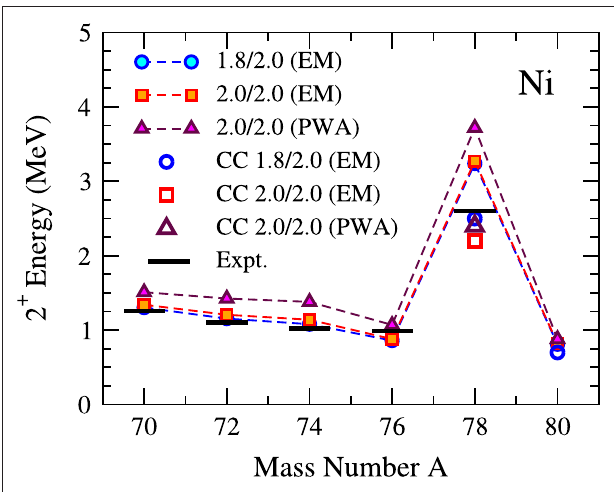
FIGURE 6 | Energies of the first excited 2 + states from VS-IMSRG [201] and Equation-of-Motion CC [ 196] calculations for several chiral two- plus three-nucleon interactions. Experimental values [201, 202] are indicated as black bars. Data courtesy of J. D. Holt, J. Menéndez, and G.